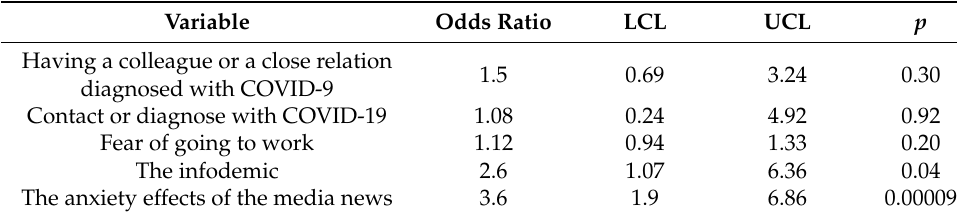
Table 3. Factors of concern about the COVID-19 infection.